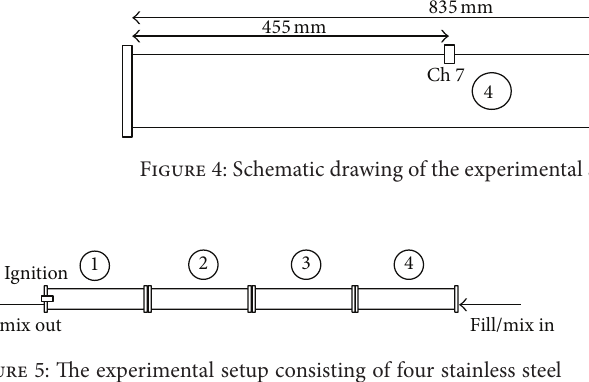
Figure 5: The experimental setup consisting of four stainless steel tube sections.